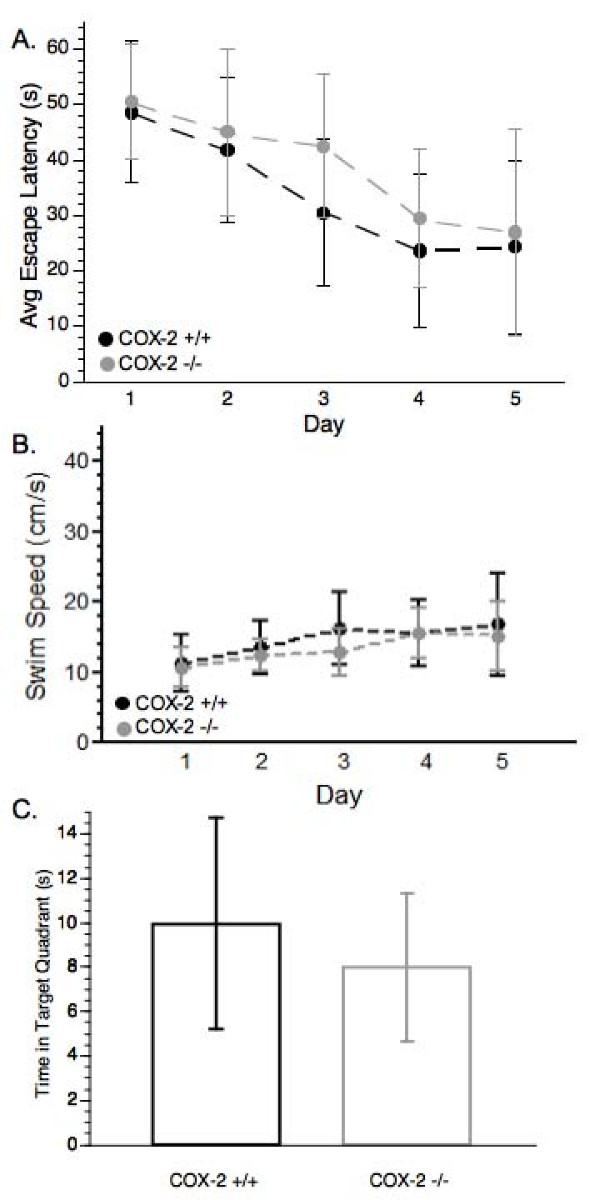
Post-injury cognitive assessment and probe trial of COX-2 +/+ and COX-2 -/- mice. (A) Post-injury MWM acquisition latency. COX-2 +/+ and COX-2 -/- mice showed a significant day effect (P < 0.0001) but no significant differences between the two genotypes. (B) Analysis of swim speed during the probe trial of the MWM. (C) Duration of time in the target quadrant during the probe trial of the MWM. Data are presented as mean ± SD.